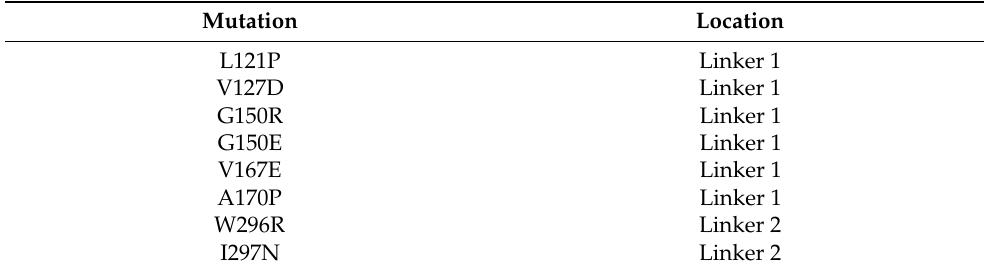
Table 1. Eight isolated single point mutations of Thermus thermophilus prokaryotic argonaute (TtAgo) loss-of-function mutants.